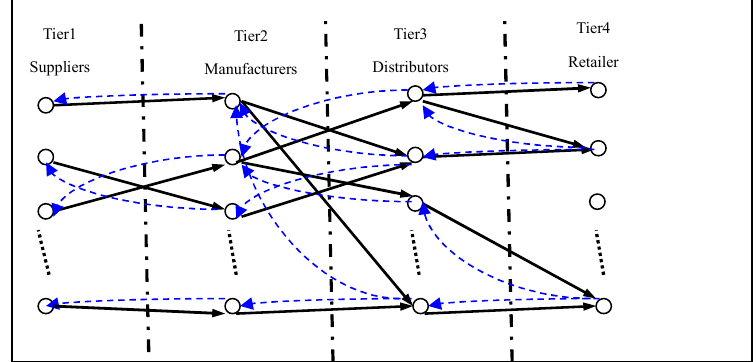
Figure 5. Structure of a supply networks.